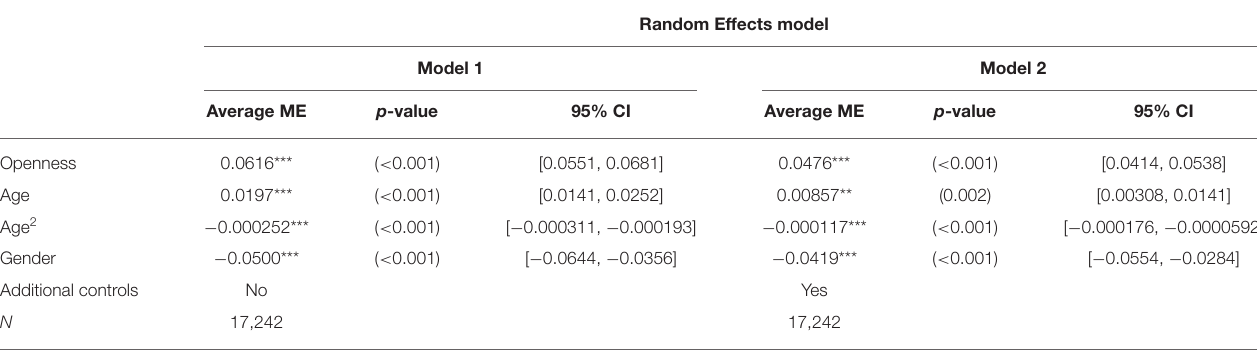
Panel B: Pooled Probit (top) and Random Effects Probit